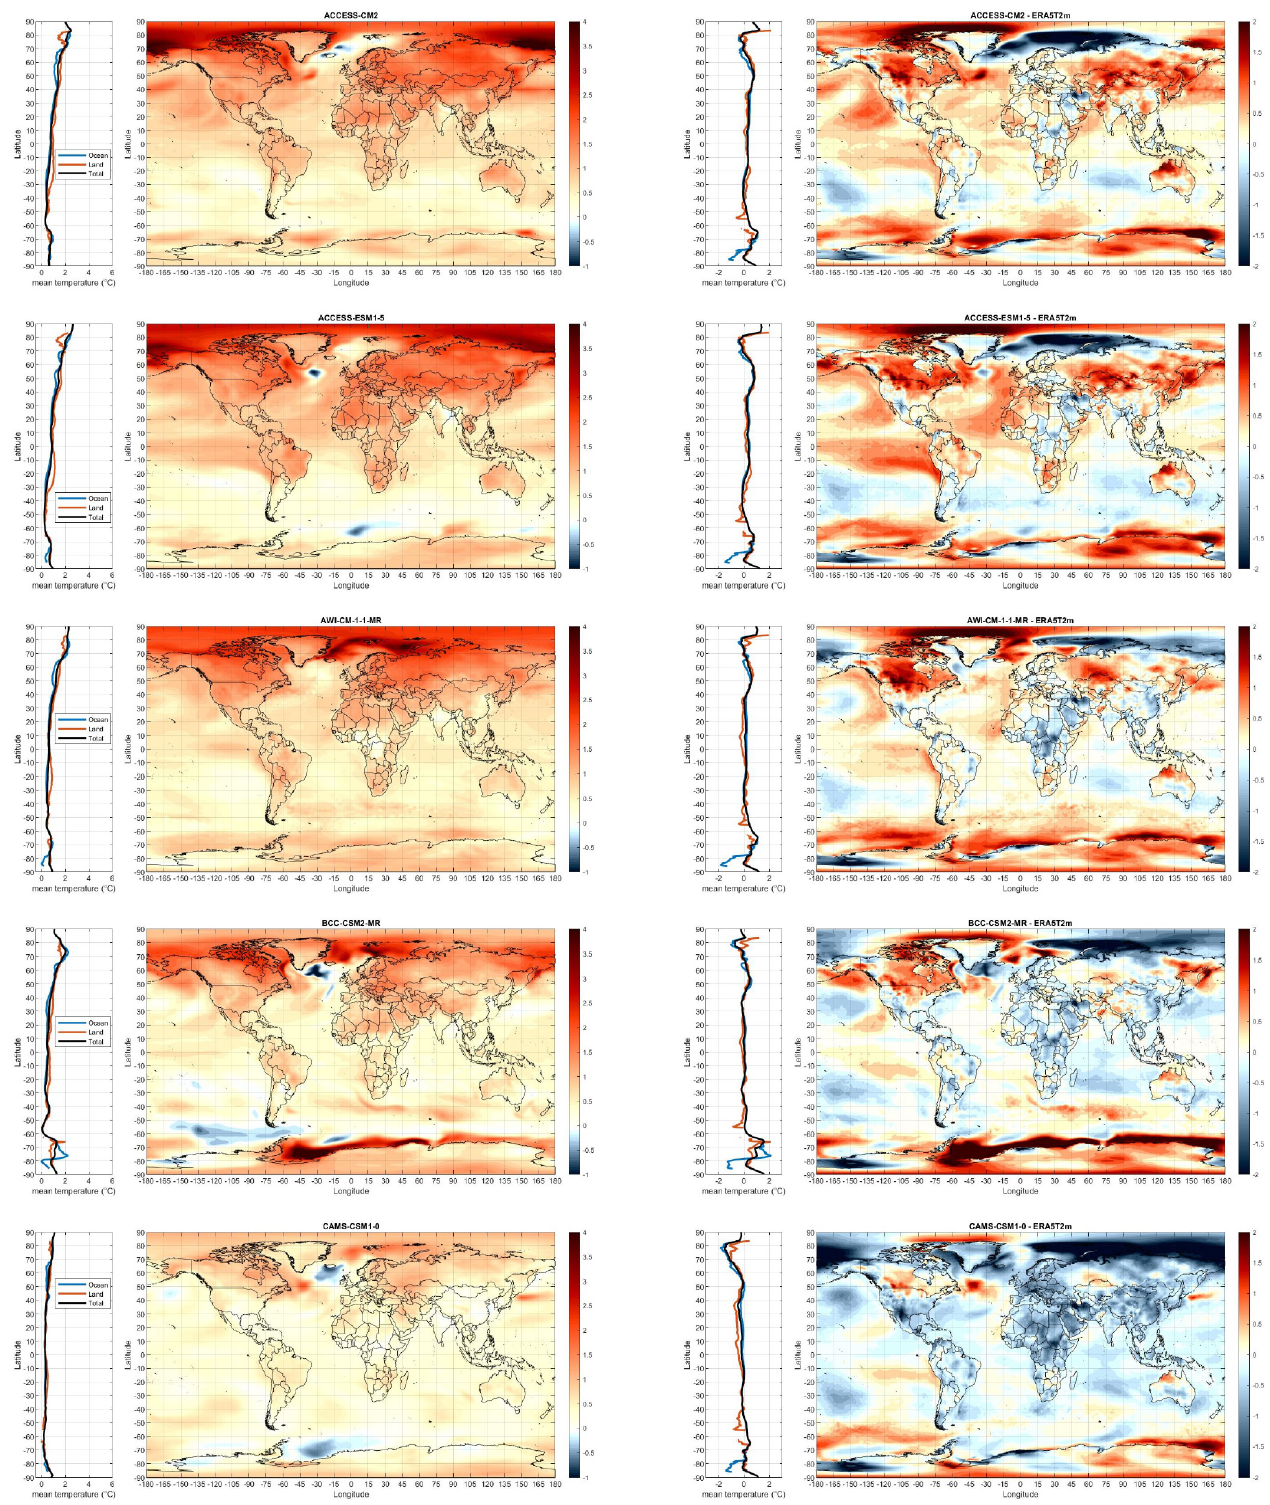
Figure A1. Warming patterns from 1980–1990 to 2011–2021 for the indicated CMIP6-tas GCM ( left ) and its comparison against the ERA5-T2m record ( right